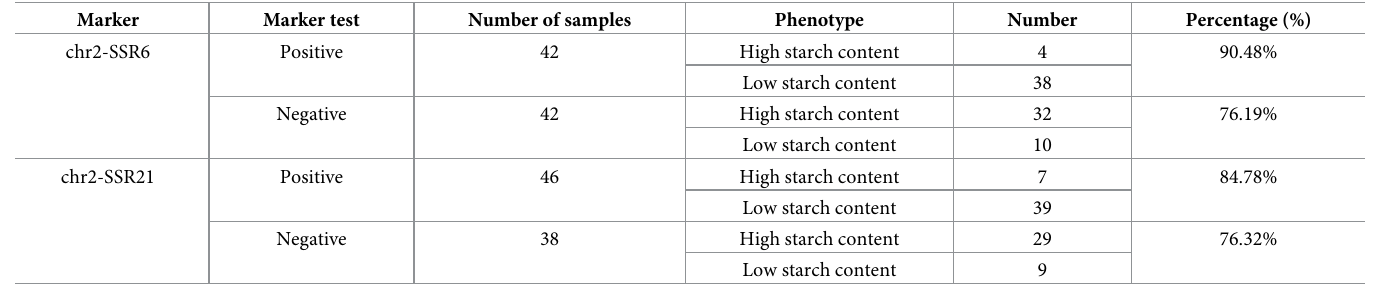
Table 4. Starch phenotype and marker detection of extreme materials in F 2 population of potato.